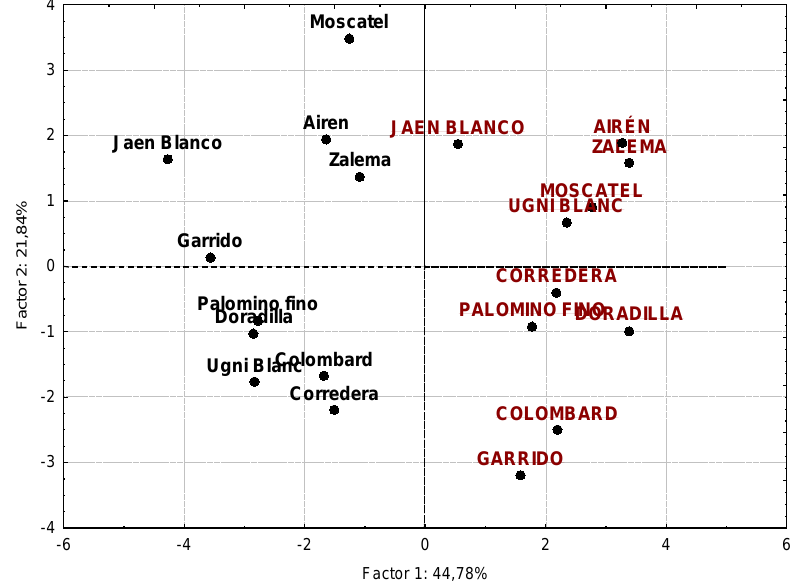
Figure 9. Principal component analysis of sensory data. Projection of the cases on the factor plane. Capital letters correspond to aged distillates and lowercase letters distillate to non-aged distillates.